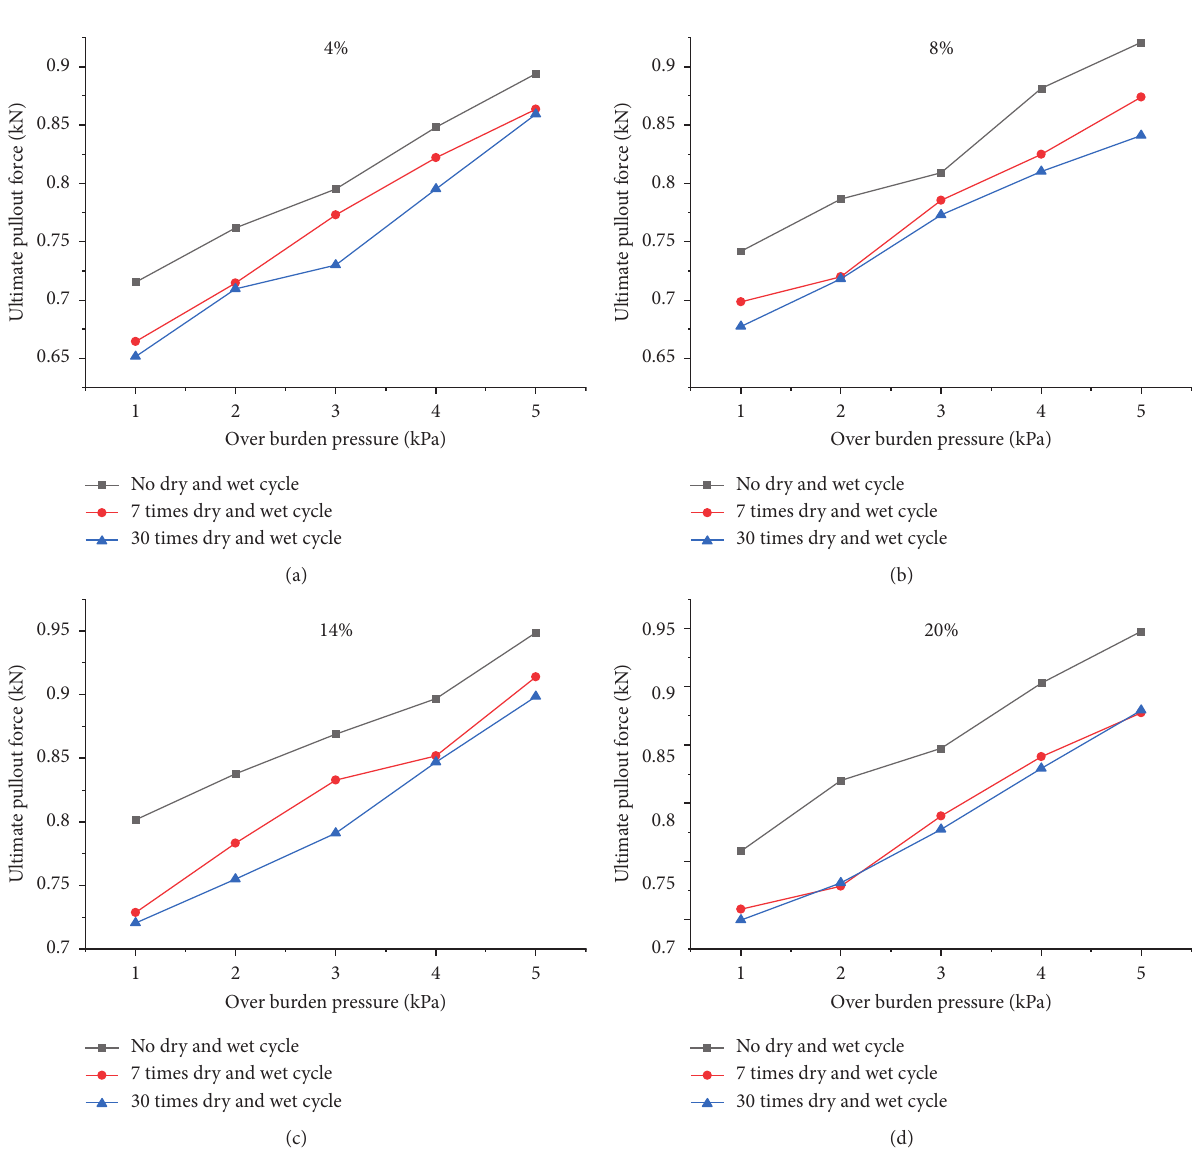
Figure 6: The ultimate pullout force-overlying pressure curve with different water content for dry-wet